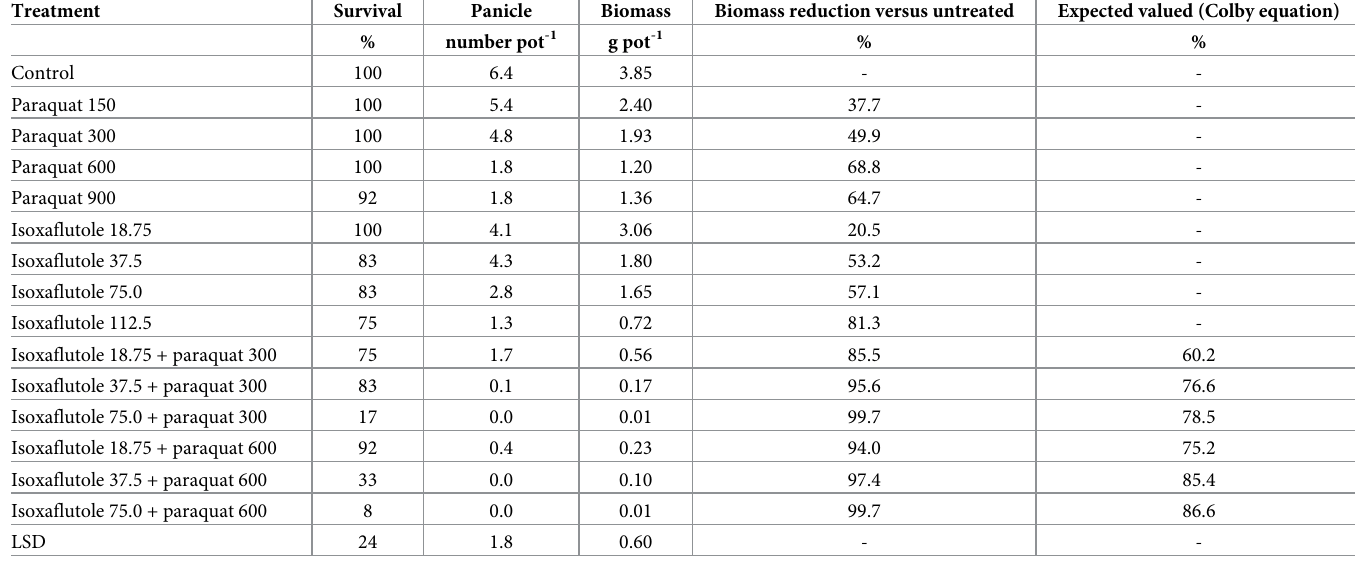
Table 5. Effect of different doses of paraquat, isoxaflutole and their mixtures on survival, panicle production, and shoot biomass of glyphosate-resistant Chloris vir- gata . Percent biomass reduction and expected Colby equation values from mixtures of isoxaflutole and paraquat were also calculated. Herbicides were sprayed at the 40– 50 leaf stage.